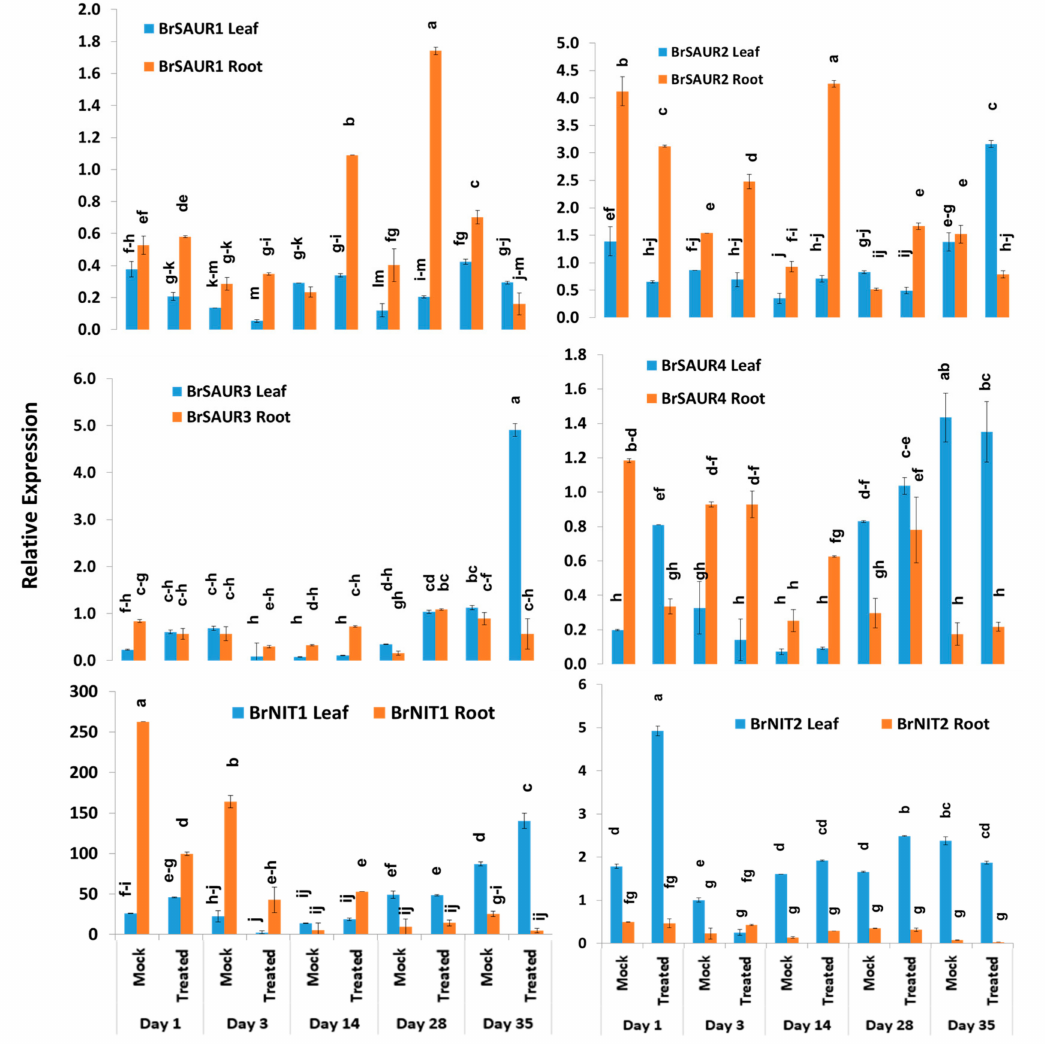
Figure 6. Variation in the relative expression levels of auxin-related genes BrNIT and BrSAUR genes in leaf and root samples under di ff erent treatment × time-point combinations: Data represent relative expression levels of three di ff erent treatment types—sample type (leaf vs. root), treatment (Seosan-inoculated vs. mock-treated), and time-points. Vertical bars represent standard deviation. Each data point estimates the average of three independent biological replicates. Data bars separated by di ff erent letters indicate the 5% statistical significance level according to Tukey’s pairwise comparisons. Expression of genes in leaf tissues of control (nontreated) plants on day 0 were set to